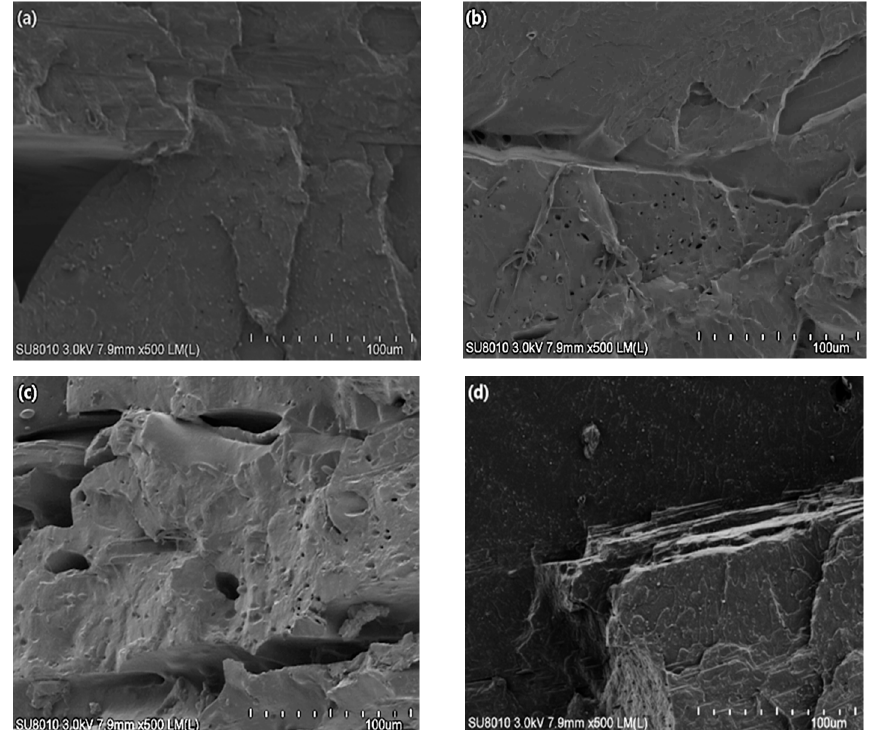
Figure 6. SEM micrograph of cross section of 3D-printed specimen of ( a ) RSP/PLA, ( b ) U-RSP/PLA, ( c ) A-RSP/PLA, and ( d ) AU-RSP/PLA. Scale bars in ( a – d ) indicate 100 μ m.